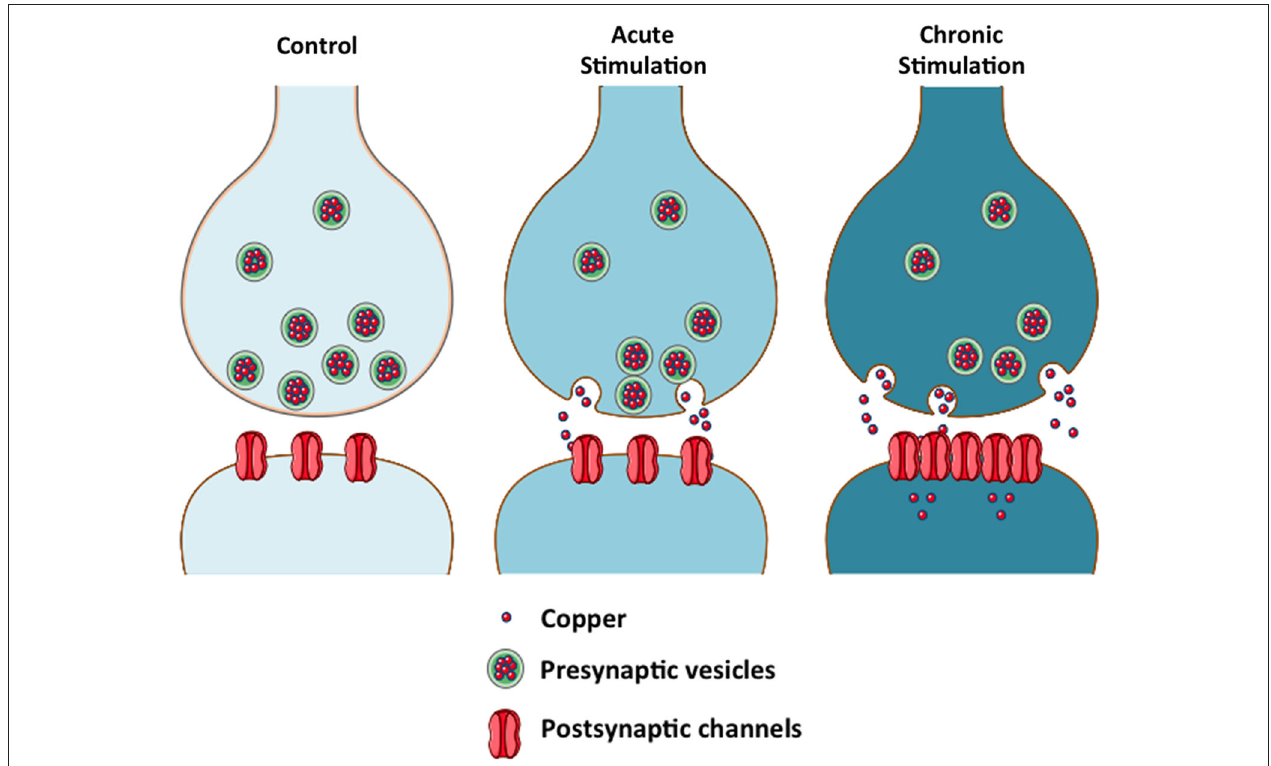
synaptic cleft will lead to an increase in intracellular copper at the postsynaptic neuron, where copper might regulate the levels of scaffolding proteins that modulate the localization of channels at the plasma membrane (Peters et al.,